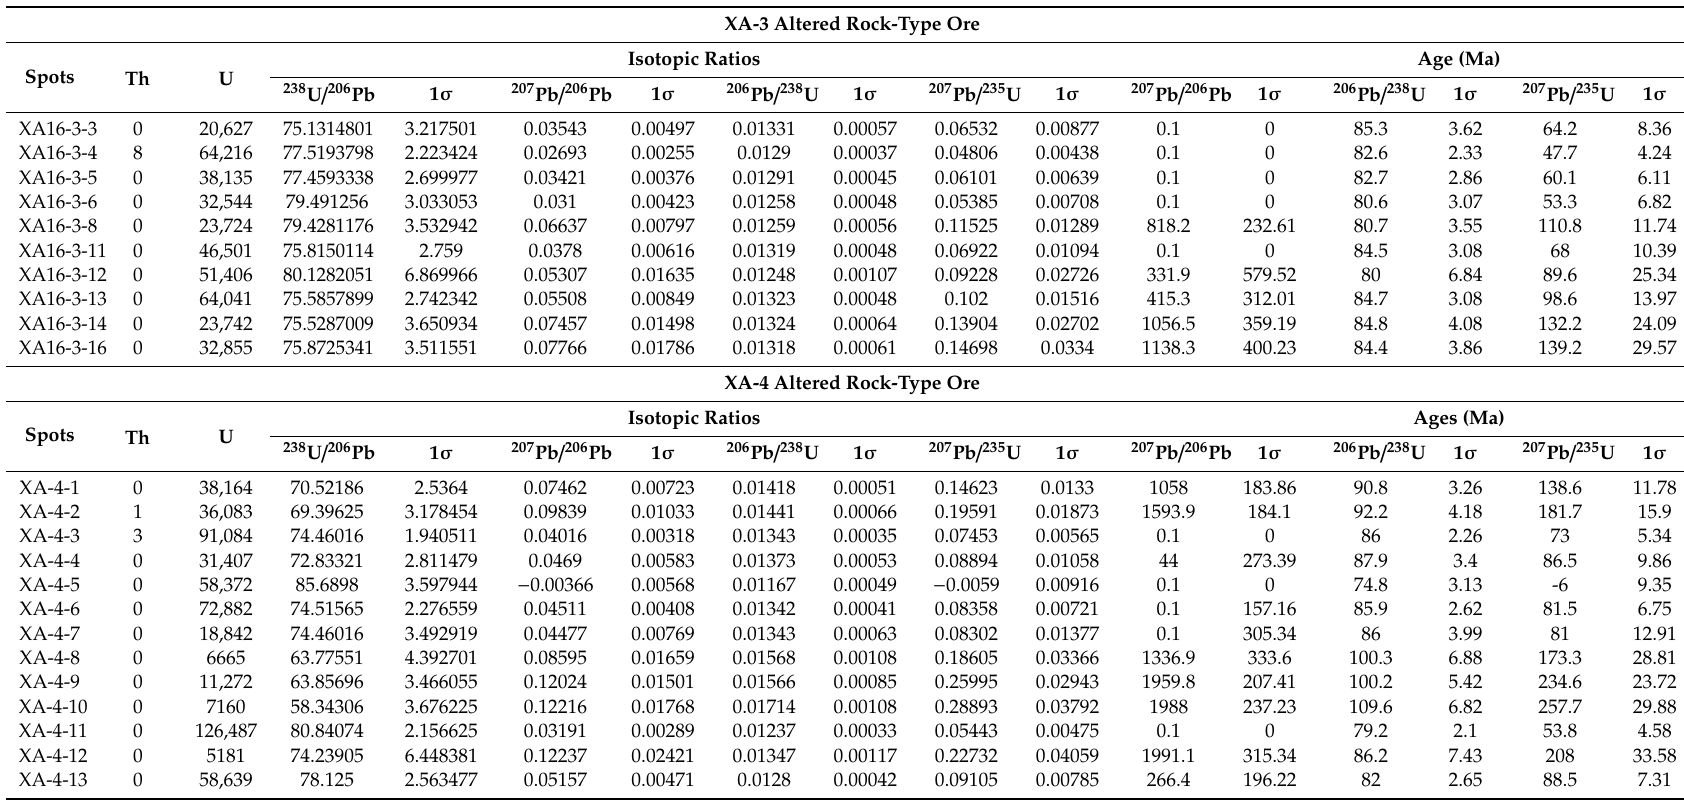
Table 6. LA-ICP-MS U-Pb dating results of cassiterite from the Xi’ao Cu-Sn polymetallic